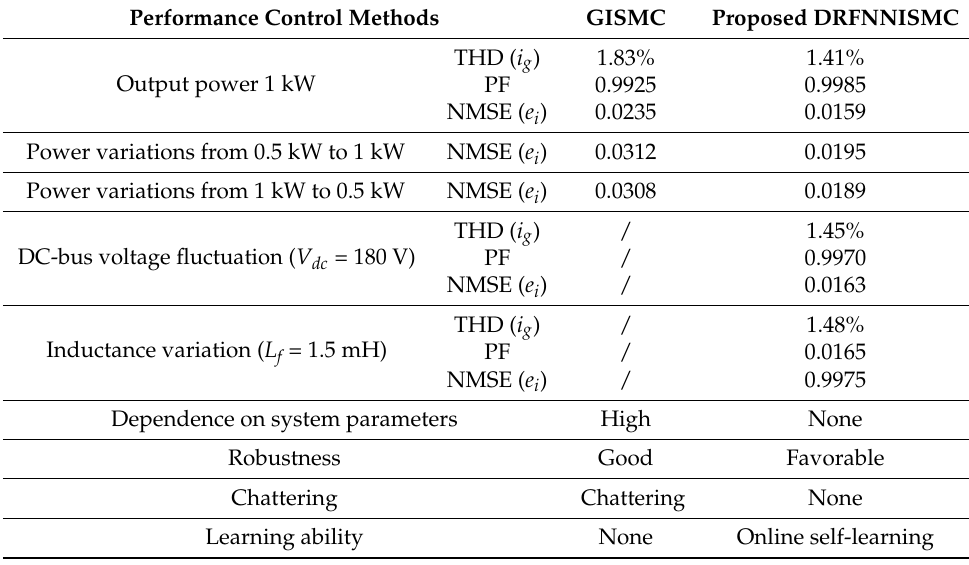
Table 2. Experimental performance comparison of two control